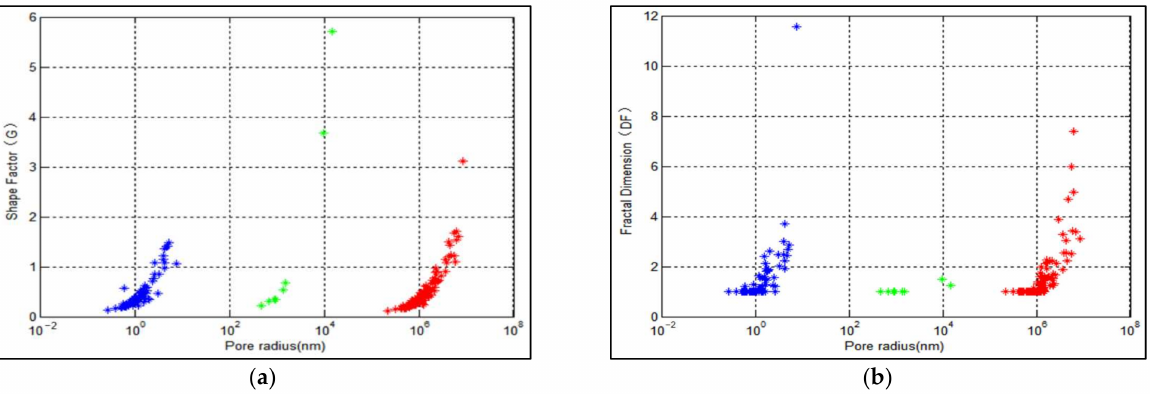
Figure 12. Distribution of multi-scale pore structure characterization parameters. ( a ) Pore radius and shape factor; ( b ) Pore radius and fractal